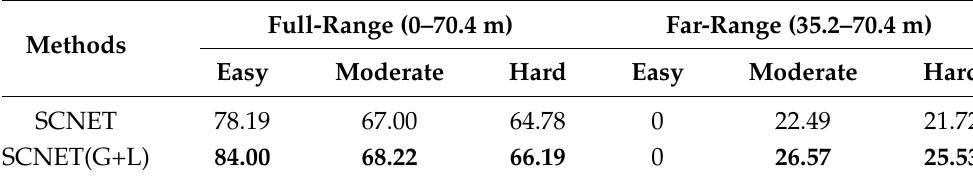
Table 5. Three-dimensional detection performance on adaptation from 64-channel data to 32- channel